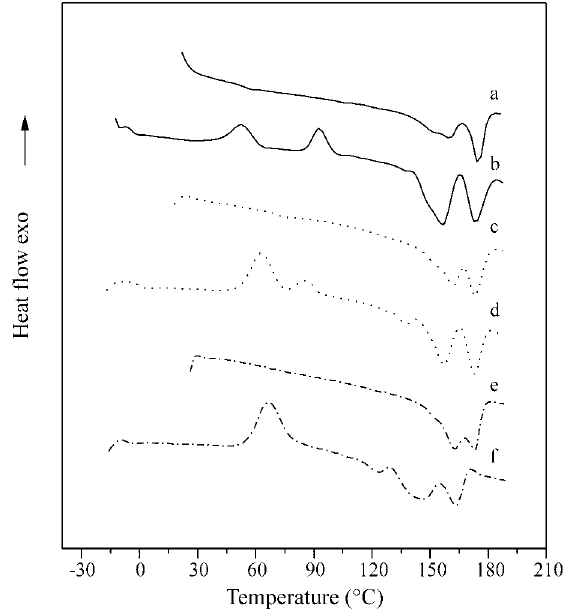
Figure 4. DSC curves for PLLA/PHBV 0/100 blends submitted to differenthydrolytic degradation periods, firstheating(a, c, e)for 0, 36 and 53 weeks, respectively and second heating (b, d,f) for 0, 36 and 53 weeks, respectively.